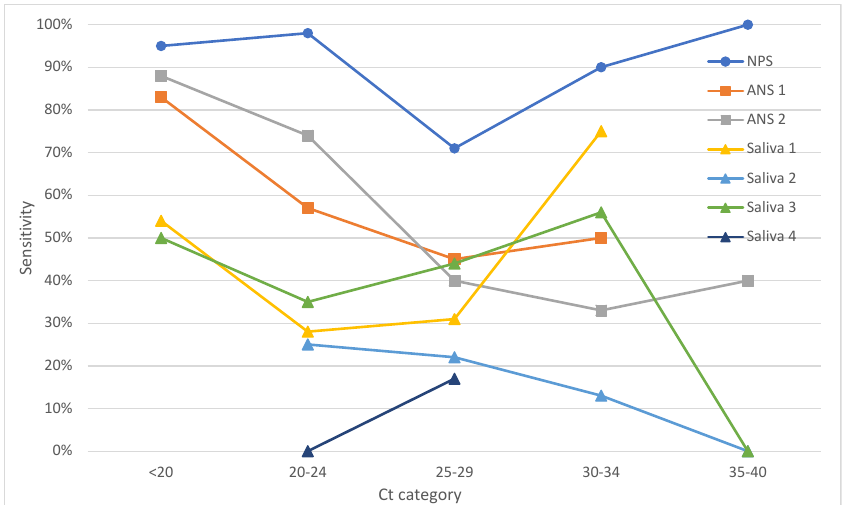
Figure 2. Sensitivities of individual tests with qPCR corrected for the culture results used as the gold standard (see Methods for more information) stratified by C t cycles; where the respective category included fewer than 5 patients, data are not presented in the graph. NPS–nasopharyngeal swab; ANS–anterior nasal swab; C t –Cycle threshold.